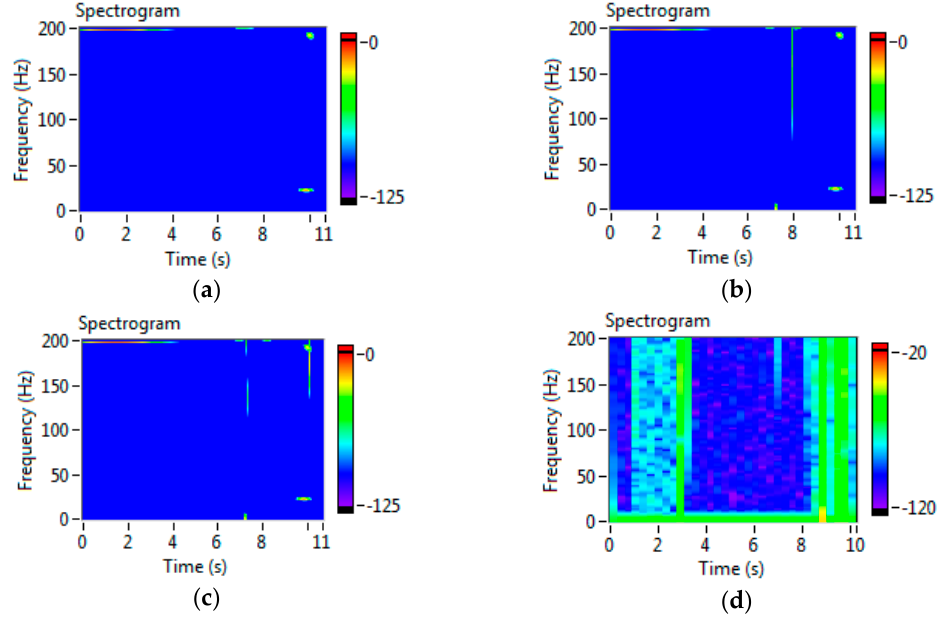
Figure 10. The adaptive spectrograms of the adaptive expansions of the tested signal for the size of a dictionary equals to: ( a ) 4; ( b ) 20; ( c ) 50 and ( d ) 200, respectively.